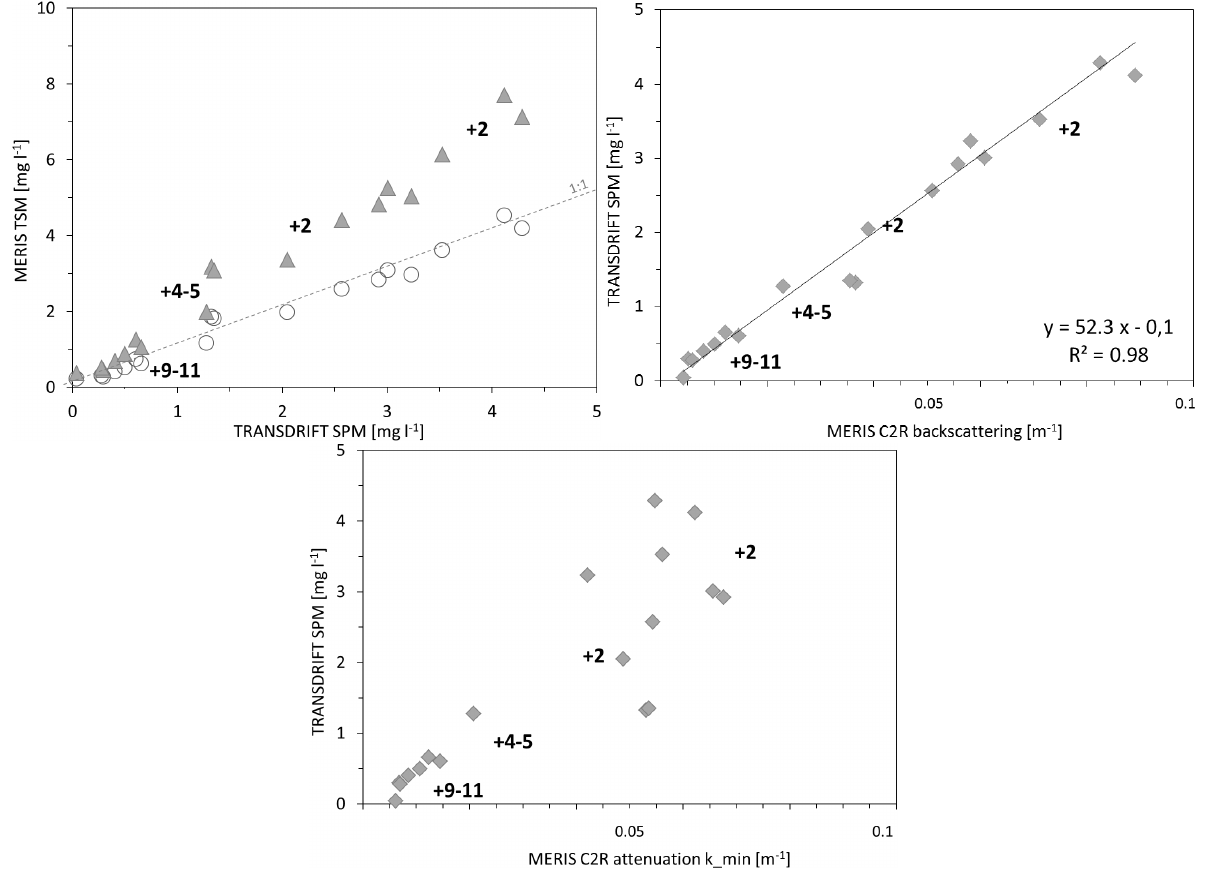
Figure 7. (upper left) Comparison of SPM (TRANSDRIFT data from 9 to 20 September 2010) vs. satellite-derived SPM (calculated from the MERIS acquisition on 7 September 2010, n = 19). SPM calculated as C2R_TSM is marked as triangles and shows the relationship C2RTSM=1.6SPM TRANSDRIFT + 0 . 2 ( R 2 = 0 . 98). SPM calculated using the Laptev Sea algorithm ( SPM=50.78 · bb spm , R 2 = 0 . 98) is marked as open circles. Numbers indicate the temporal differences in days of the in situ sampling in relation to 7 September 2010. All selected MERIS values are without cloud contamination. (upper right) Comparison of in situ SPM (TRANSDRIFT data from 9 to 20 September 2010) vs. satellite-derived backscattering, C2R_bb_SPM (m − 1 ) (calculated from the MERIS acquisition on 7 September 2010, n = 19). SPM TRANSDRIFT = 52 . 31 · bb_SPM − 0.09, R 2 = 0 . 98. (lower centre) Comparison of in situ SPM (TRANSDRIFT-XVII data from 9 to 20 September 2010) vs. satellite-derived attenuation, C2R k min (m − 1 ) (calculated from the MERIS acquisition on 7 September 2010, MERIS TSM, n = 19). SPM TRANSDRIFT = 5 . 15 · k min − 0 . 04, R 2 = 0 .